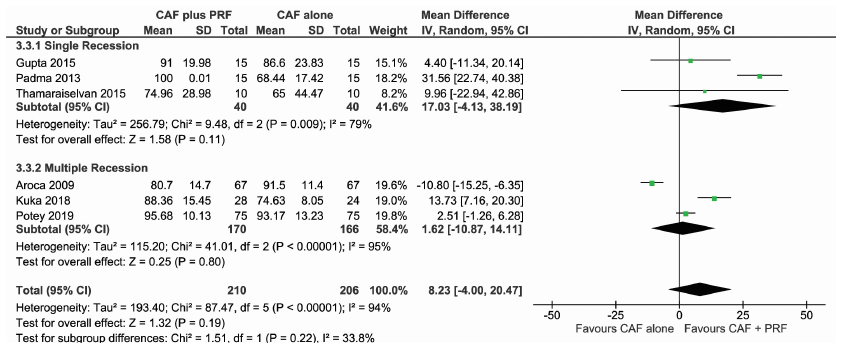
Figure 4. Comparison of change in root coverage percentage (%RC) between CAF + L-PRF versus CAF alone with 6–12 months follow-up.